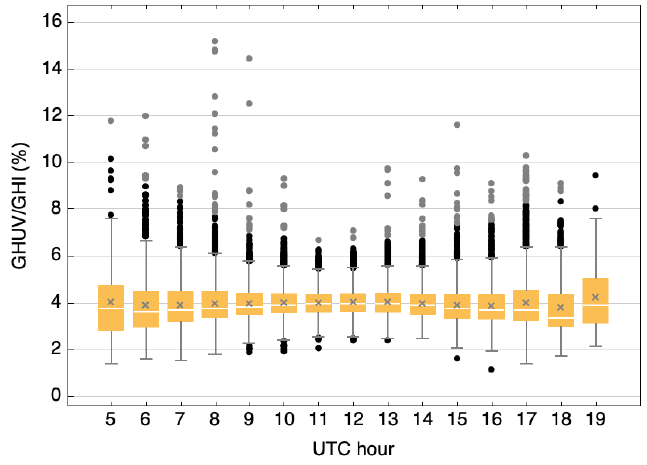
Figure 6. Boxplot of the GHUV/GHI hourly averages using the 10 min data. Gray crosses indicate the mean, and the white lines inside the box indicate the median. The limits of the boxes define the first, second, and third quartiles, whereas the extreme whiskers show the minimum and the maximum points. Black and gray circles represent outliers.